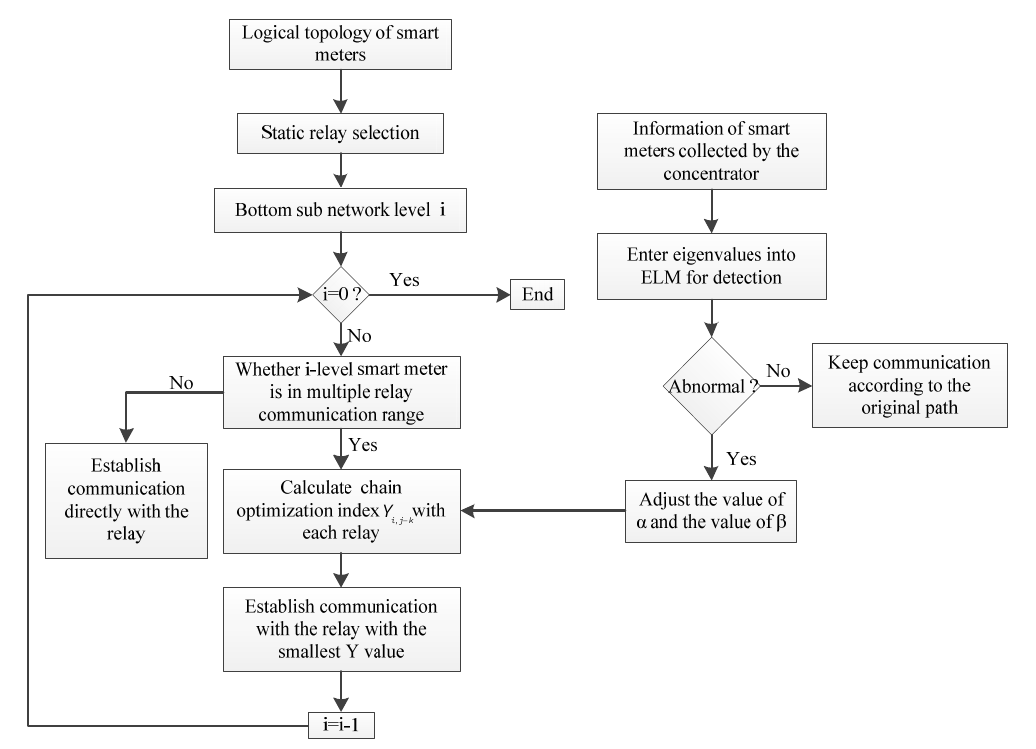
Figure 13. Schematic overview of the paper.